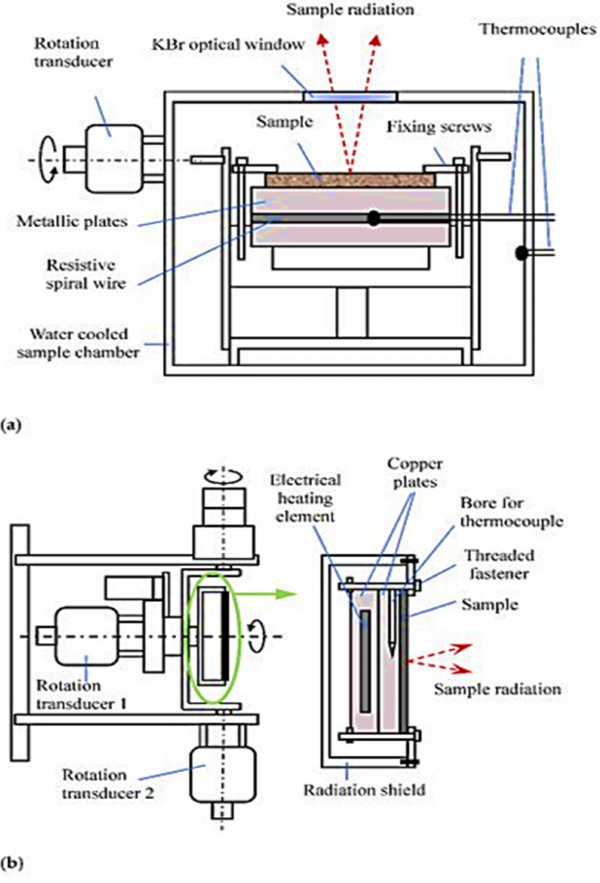
Figure 13. Contact electric heating device ( a ) del Pais Vasco Laboratory of University of Spain [67] and ( b ) Helmut-Schmidt University Laboratory, Germany